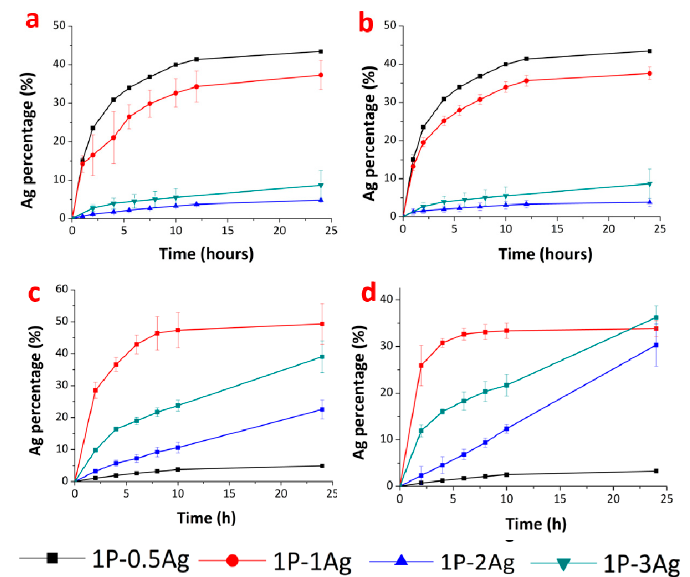
Figure 13. Cumulative silver ion release kinetics at 25 °C ( left ) and 37 °C ( righ t) for the polymer A ( a , b ) and for the polymer D ( c , d ).